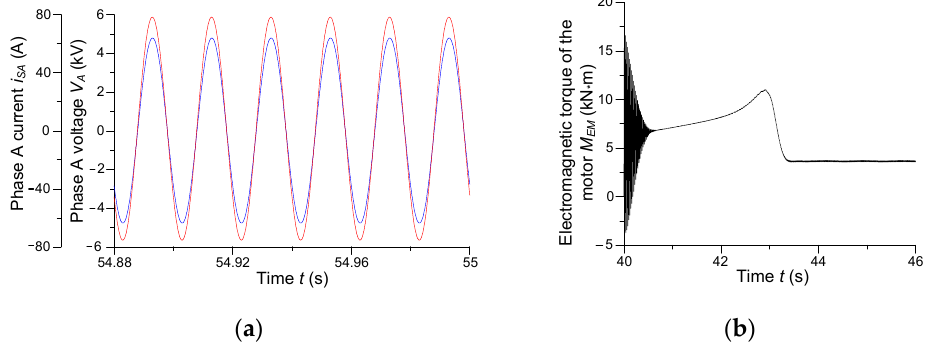
Figure 18. Instantaneous waveforms of: ( a ) phase A voltage (blue) and current (red) of the armature winding; and ( b ) electromagnetic torque of the first asynchronous motor. The voltage is blue and the current is red in the time interval t ∈ (54.88; 55) s in Figure 18a. A synchronous motor is a purely resistive load of the network, i.e., ϕ = 0 ◦ . We